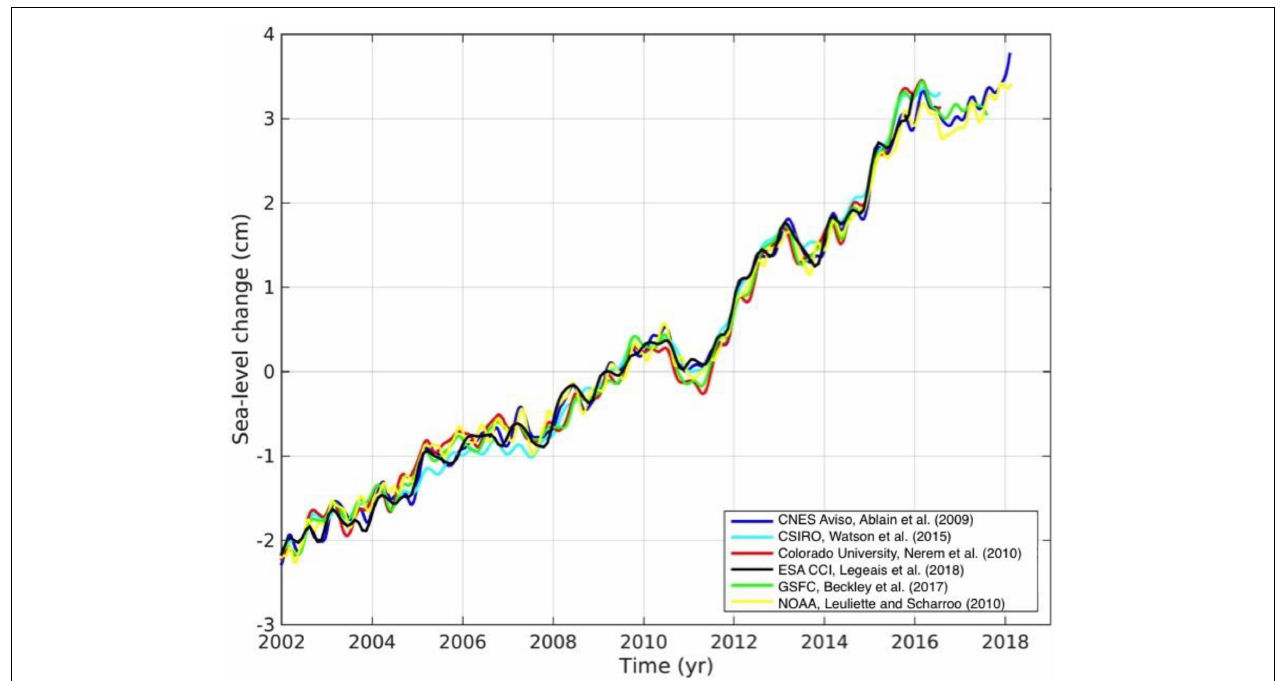
FIGURE 6 | Global mean sea level changes estimated from satellite altimetry by CNES Aviso, CSIRO, Colorado University, Copernicus Climate service, ESA CCI, GSFC, and NOAA.